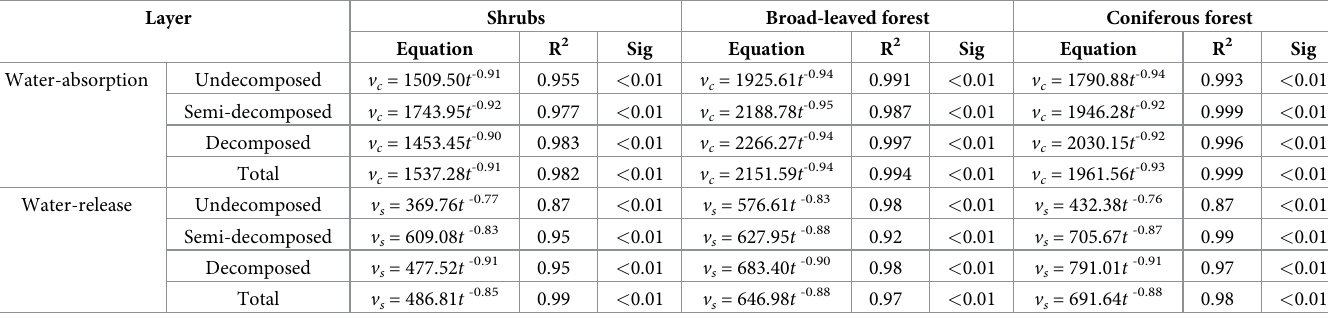
Table 3. The regression equation of the litter water-absorption/release rate and time.